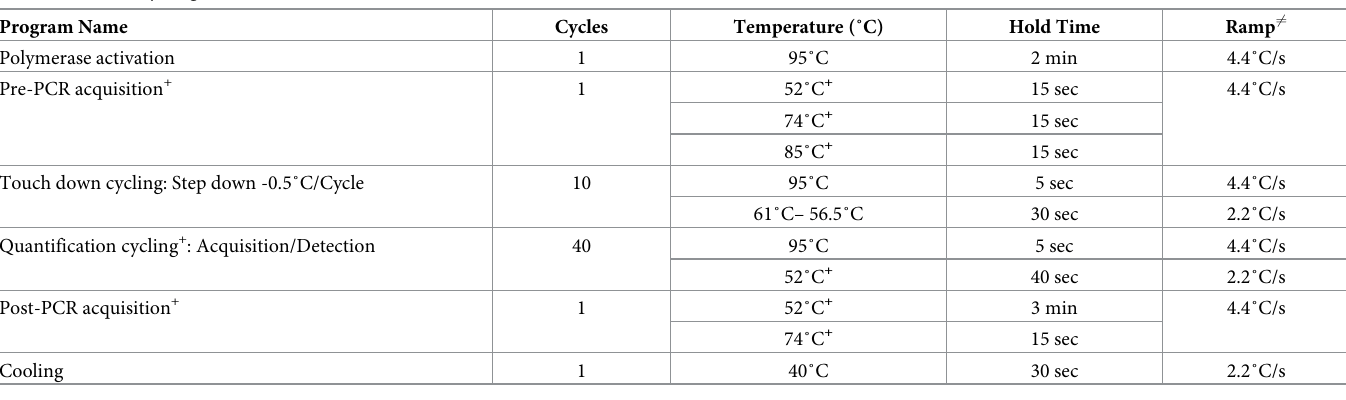
Table 1. Thermocycling conditions for PlexProbe